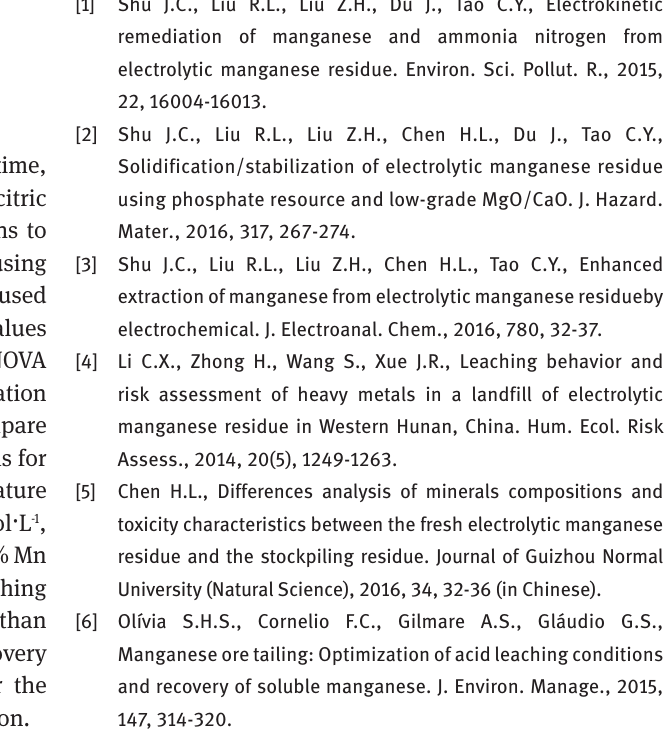
Table 7: The main constituents of EMR (wt%) after leaching with different methods. Method SiO Conventional heating Microwave assisted